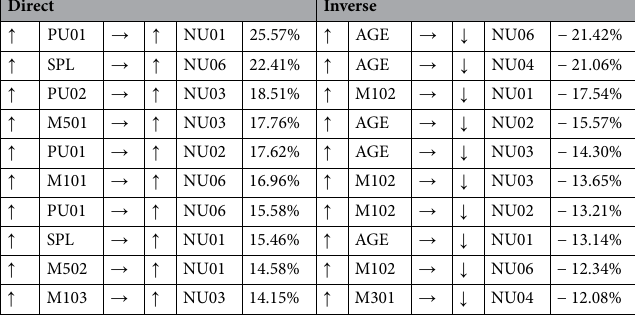
Table 7. Items with the greatest influence on negative